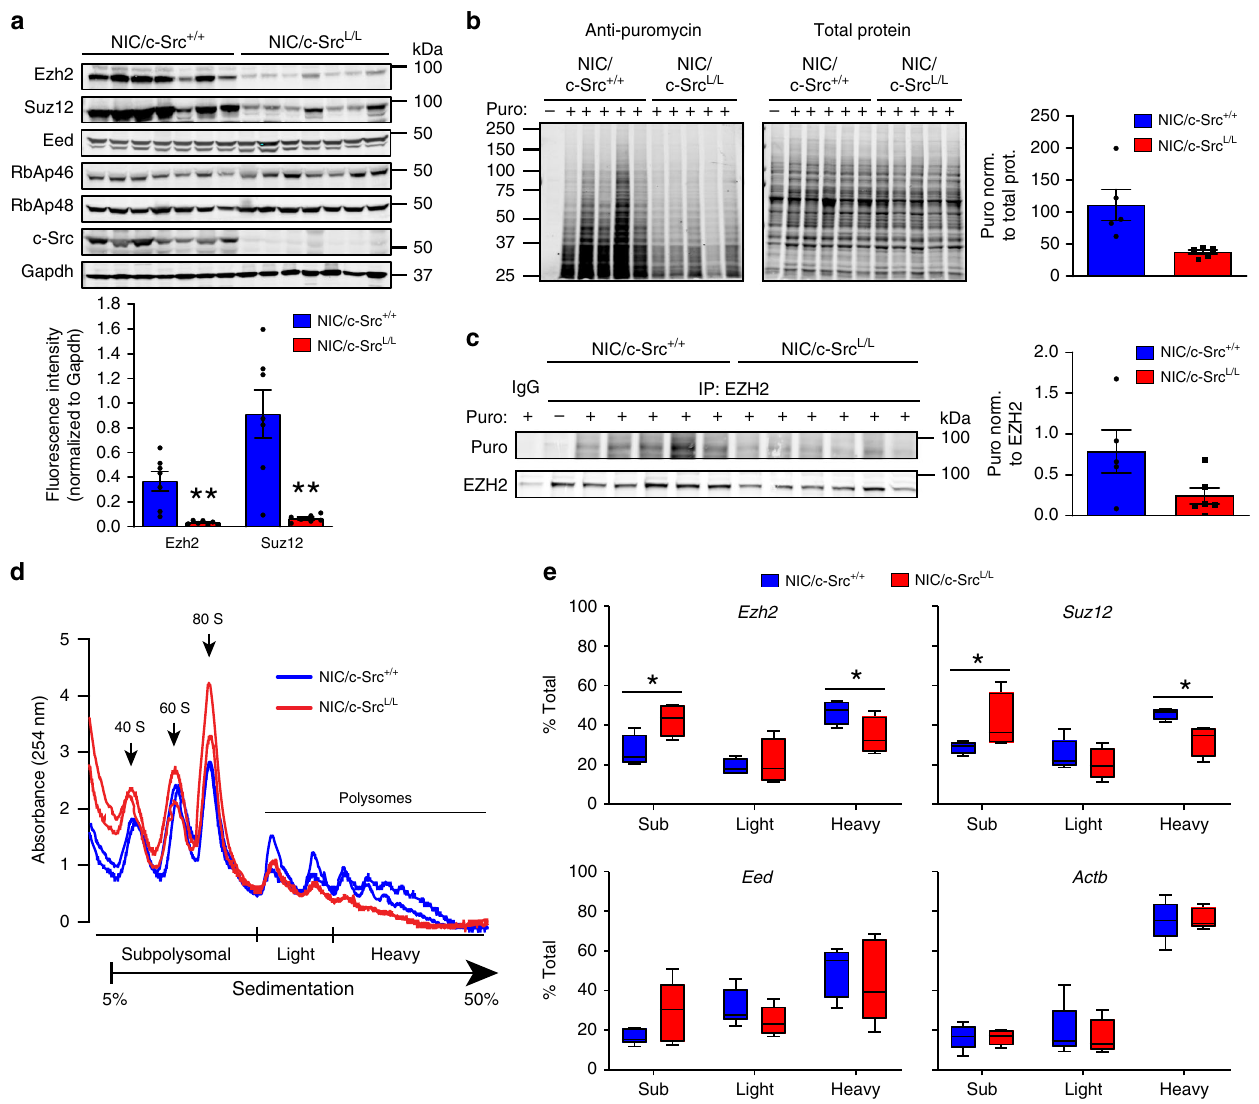
Fig. 2 c-Src is required for ef fi cient translation of PRC2 component mRNAs. a Immunoblot of PRC2 components in control and c-Src-de fi cient tumors. Bar chart shows quanti fi cation of fl uorescent immunoblot data normalized to the loading control (Gapdh). b Protein synthesis in NIC/c-Src + / + and NIC/c-Src L/L cells was assessed using puromycin incorporation with immunoblotting (Surface sensing of translation (SUnSET) assay). Images show detection of puromycylated nascent proteins (left) and total cellular protein (right) following a 30 min. treatment with puromycin (puro). Bar chart shows the puromycin signal in each lane normalized to total protein levels ( n = 5 per genotype). c Ezh2 was immunoprecipitated from NIC/c-Src + / + and NIC/c-Src L/L cells treated as in b and newly synthesized Ezh2 was detected by immunoblotting with anti-puromycin (puro) and anti-Ezh2 antibodies. Immunoprecipitation with non-speci fi c IgG and Ezh2 immunoprecipitation from untreated cells were used as controls. Bar chart shows quanti fi cation of the puromycin signal in Ezh2 immunoprecipitations normalized to the total Ezh2 levels precipitated ( n = 5 per genotype). d Representative polysome pro fi les of two NIC/c-Src + / + and two NIC/c-Src L/L tumor cell lines. Pro fi les are representative of fi ve biological replicates per genotype. e qRT-PCR analysis of mRNAs isolated from polysome pro fi ling of NIC/c-Src + / + and NIC/c-Src L/L tumor cell lines (5 biological replicates per genotype). In the box and whisker plots, the center line represents the median, boundaries are the 25th and 75th percentiles and whiskers were calculated according to Tukey ’ s method. For all data, * = p < 0.05 and ** = p < 0.01 (unpaired, two-tailed Student ’ s t -test). For all bar charts, error bars are TMA series containing 131 patient samples of ERBB2 + breast mTORC1 activation (as assessed by EIF4EBP1 phosphorylation) cancer to con fi rm these correlations speci fi cally within this sub- and the expression of EZH2 and SUZ12 proteins (Fig. 4d, e). We type (Fig. 4c). Functional relationships were assessed in a human con fi rmed that these effects were not due to changes in the breast cancer setting by treating immunocompromised mice expression of mTORC1 component proteins (Supplementary bearing patient-derived xenografts (PDXs) established from two Fig. 5e), although phosphorylation of mTOR (Ser2448) and ERBB2 + tumors with the SFK inhibitor Dasatinib or the active PRAS40 (Thr246) was reduced in Dasatinib- and AZD2014- site-directed mTOR inhibitor AZD2014, both of which are cur- treated tumors. Reduced EZH2 expression and diminished rently involved in multiple clinical trials. These inhibitors atte- H3K27me 3 in Dasatinib- and AZD2014-treated tumors were validated by immunostaining (Fig. 4f, Supplementary Fig. 5f). nuated tumor growth, with AZD2014 exerting the most signi fi cant effects (Supplementary Fig. 5c, d) and also reduced